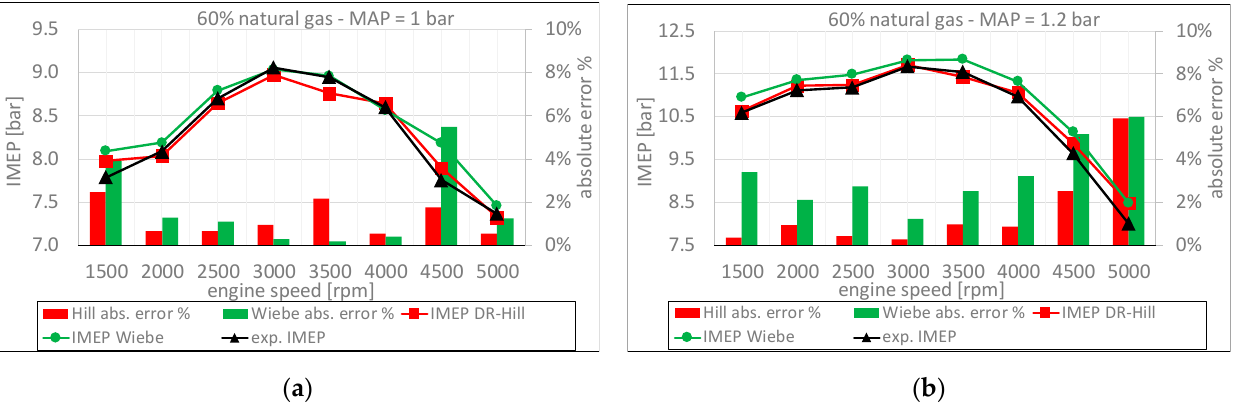
Figure 4. Comparison between the experimental and simulated IMEP; 60% NG fuel mixture. ( a ) MAP = 1 bar; ( b ) MAP = 1.2 bar.